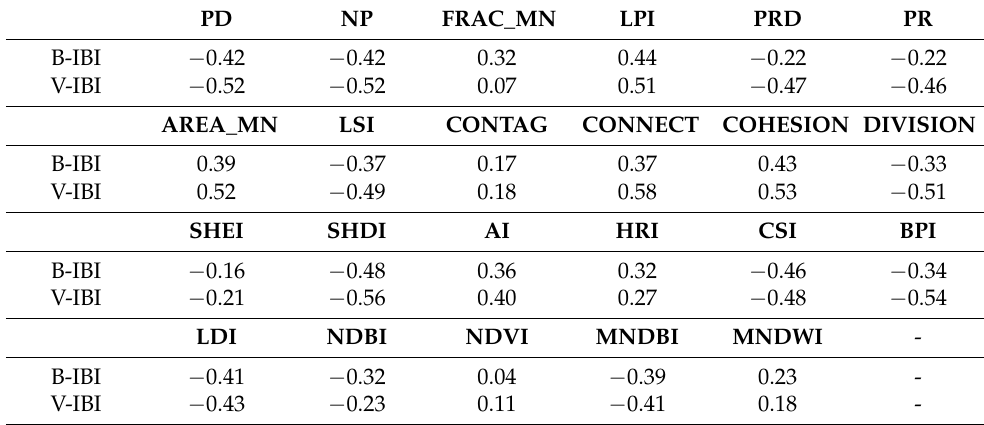
Table 2. Pairwise Pearson’s correlation coefficients of nine candidate metrics.